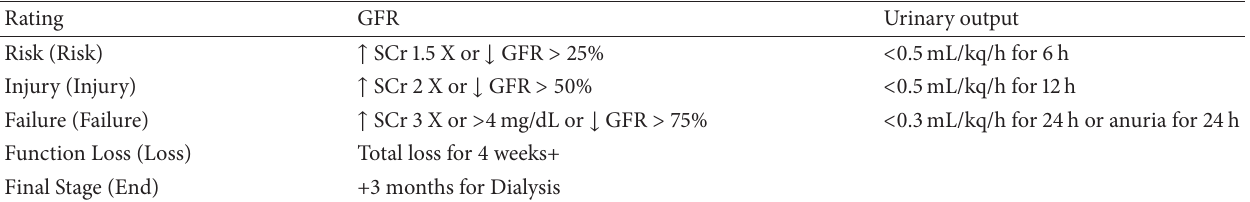
Table 1: RIFLE classification for acute kidney